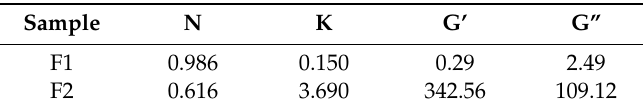
Table 2. Rheological parameters of hydrogels composed of poloxamer 407 dispersion (1%), oleic acid, and PPG-5-CETETH-20 systems.